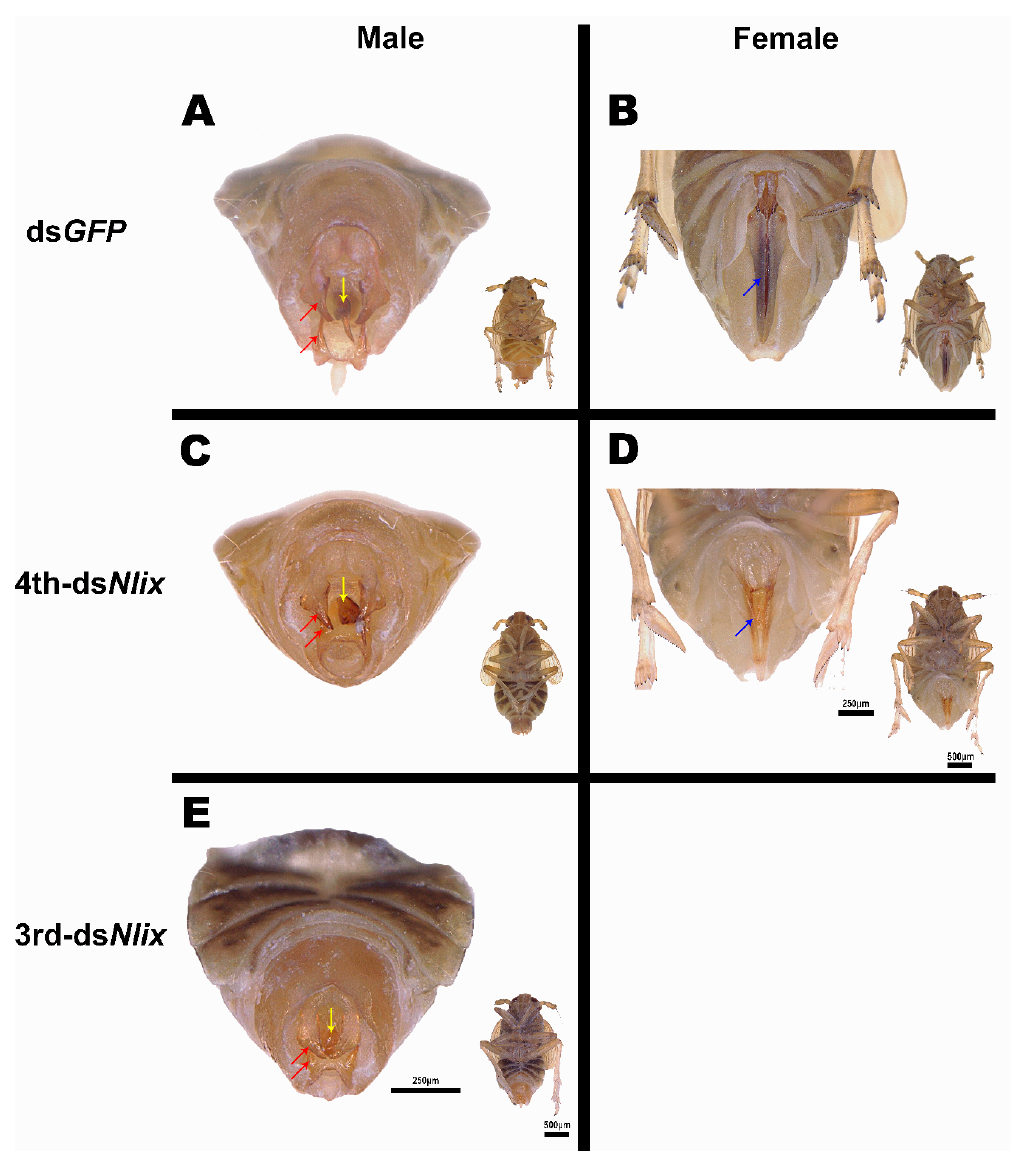
Figure 5. The external genitalia of BPH adults injected with ds GFP and ds Nlix . ( A , B ) The abdomen of female BPHs treated with ds GFP and ds Nlix for 4th instar nymphs. The ovipositors of ds Nlix -treated females were deformed. ( C – E ) The abdomen of male BPHs treated with ds GFP and ds Nlix for 3rd and 4th instar nymphs. The size of external genitalia was reduced in ds Nlix -treated males. The red arrow: harpagones; the yellow arrow: aedeagus; and the blue arrow: ovipositor. Images at the bottom right are the full images of treated BPH.